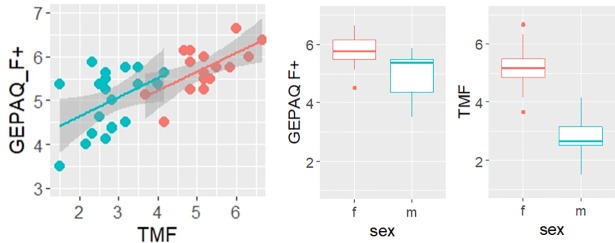
Self-rated gender identity.Left plot: Relationship between GEPAQ_F+ and TMF scores of 20 male (blue) and 17 female (red) speakers. Right plots: Distribution of GEPAQ_F+ and TMF scores: the horizontal line marks the median of the group (females: red, males: blue), the boxes comprise 50% of the data: The whiskers extend to the most extreme data point, which is no more than 1.5 times the interquartile range from the box; outliers are marked with dots.